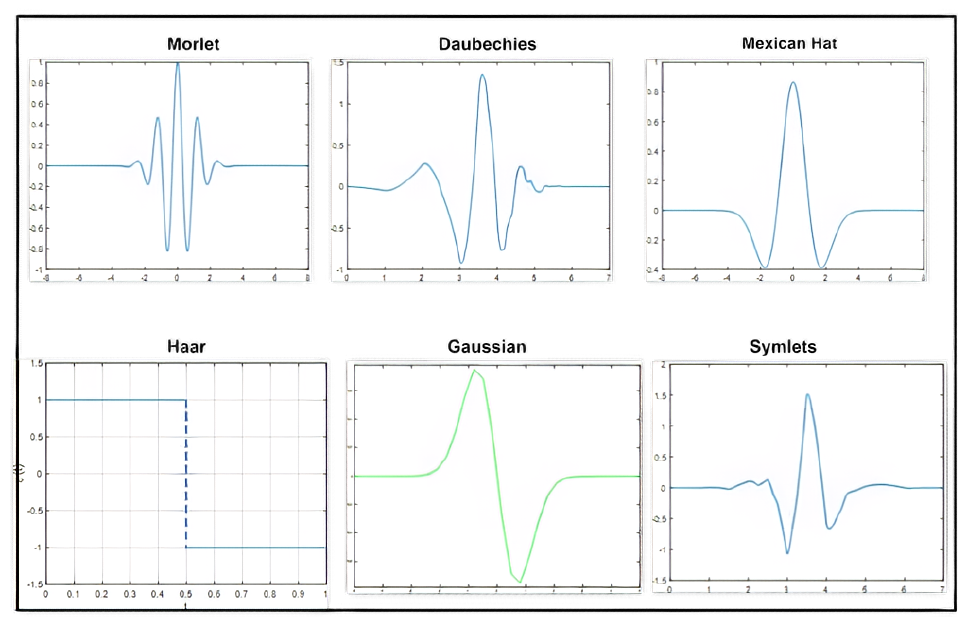
Figure A1. Wavelet